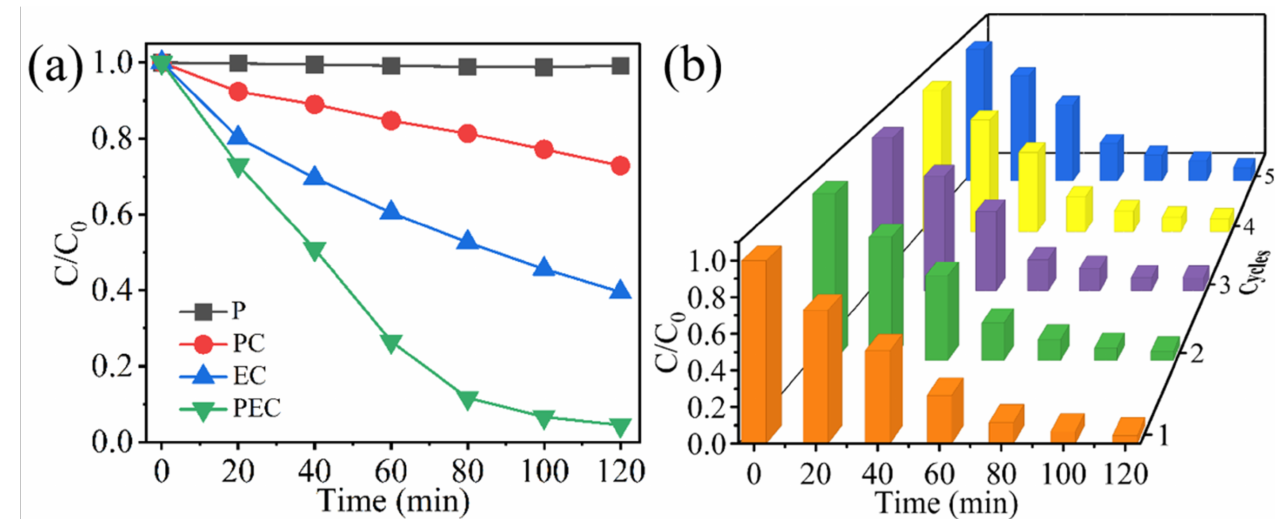
Figure 11. ( a ) Different degradation systems (P: photolytic, PC: photocatalytic, EC: electrocatalytic, and PEC: photoelectrocatalytic) and ( b ) reliability experiments of the MBI2 sample for the PEC degradation of TC under visible light ( λ > 420